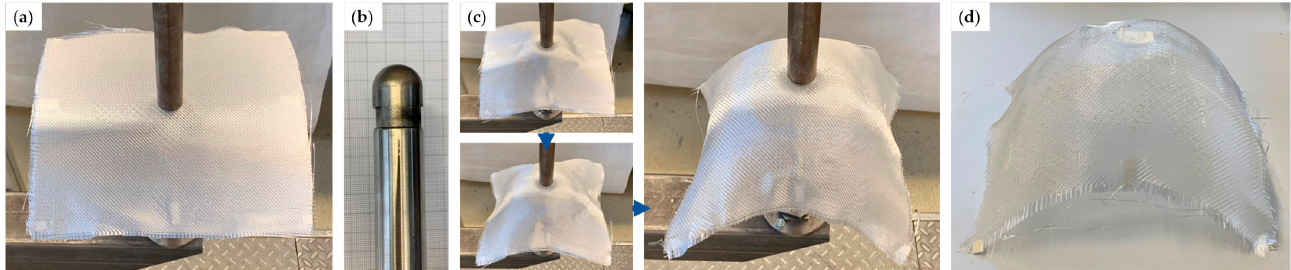
Figure 14. ( a ) Glass fiber fabric supported by metal wire mesh, centrally clamped between two poles; ( b ) Hemispherical tool tip used for dieless forming; ( c ) Forming sequence according to layering strategy and formed hemisphere; ( d ) Final glass FRP after curing and removal from wire mesh.